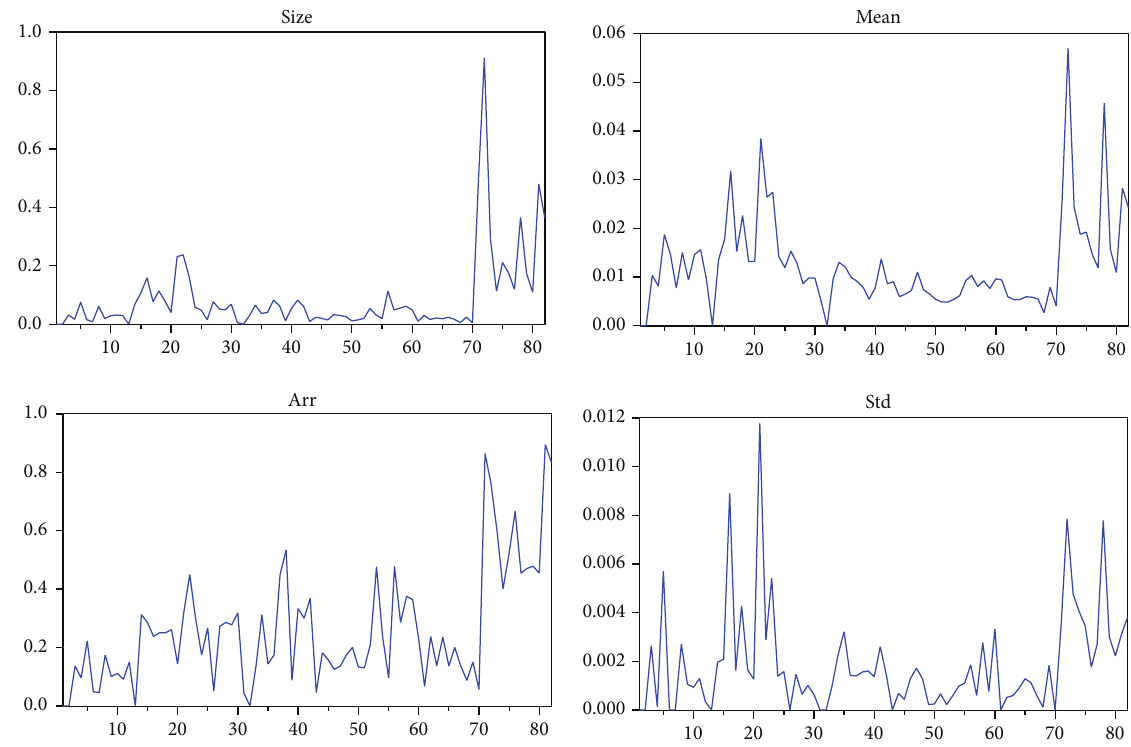
Figure 1: Time series characteristic of index jump components.